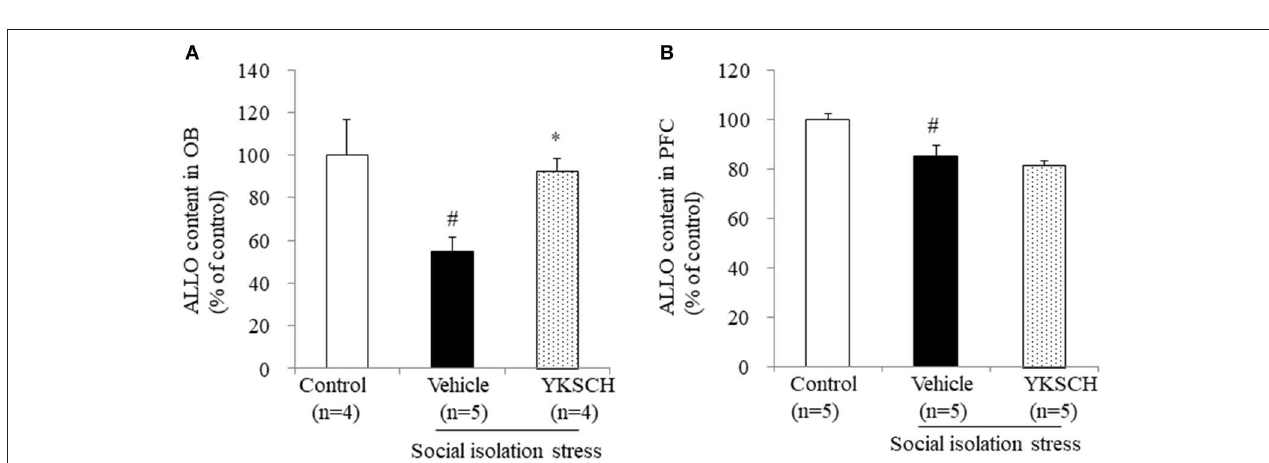
FIGURE 6 | Effect of YKSCH on allopregnanolone content in the olfactory bulb and prefrontal cortex. Allopregnanolone content in the OB (A) and PFC (B) . Data are expressed as the mean ± SEM ( n = 4–5). # p < 0.05 vs. the control group; * p < 0.05 vs. the vehicle-treated group, Peritz’s F